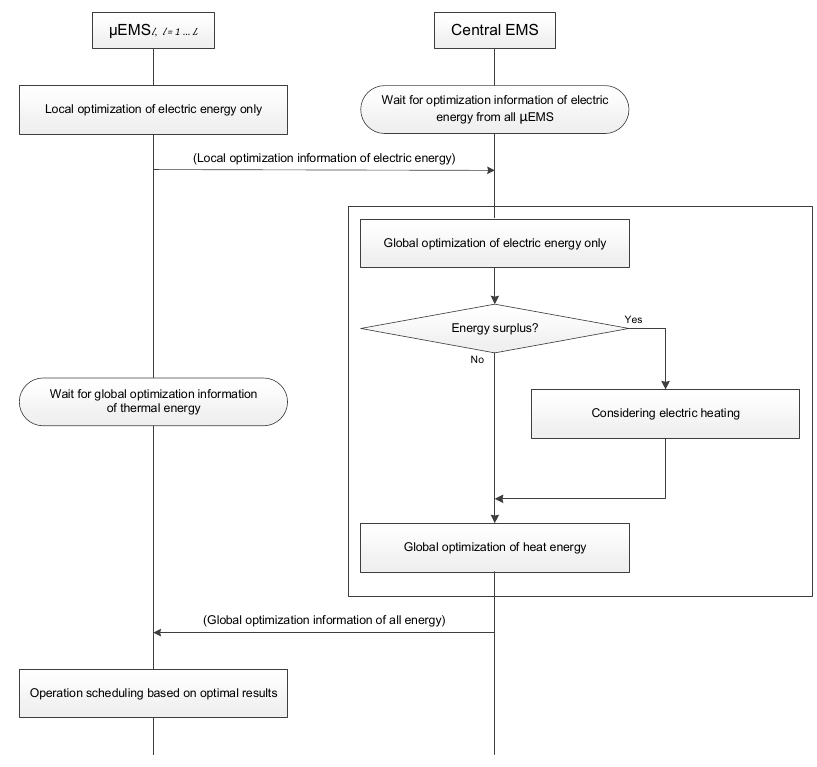
Figure 2. Operation process of the cooperative multi ‐ microgrid community.